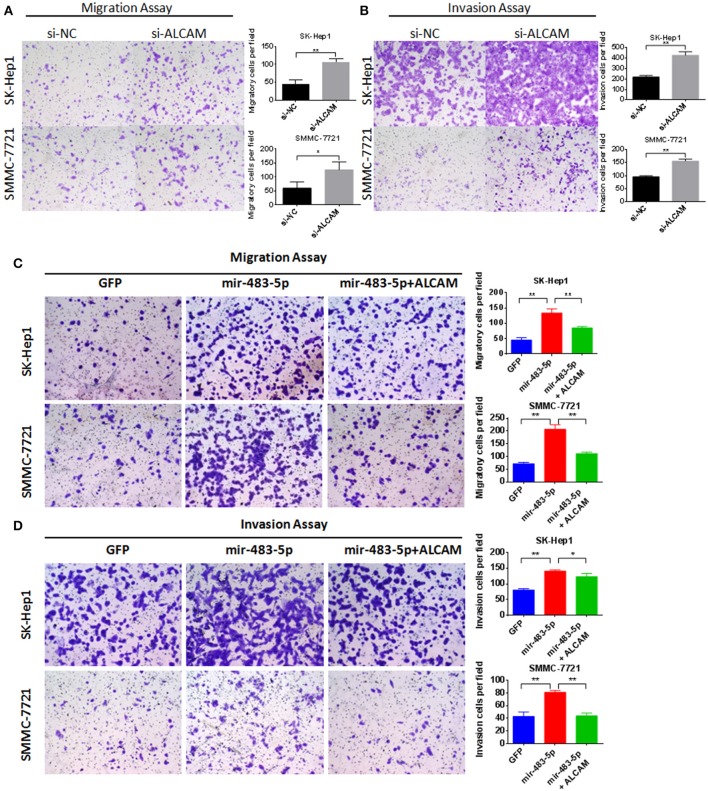
Knockdown of ALCAM can promote HCC cell migration and invasion. Restoration of ALCAM reverses miR-483-5p-mediated HCC cell migration and invasion. (A) Transwell migration assay of SK-Hep1 and SMMC-7721 showed transfection of ALCAM siRNAs promoted cell migration. (B) Transwell invasion assay showed transfection of ALCAM siRNAs promoted cell invasion. (C) The migration of HCC cells induced by miR-483-5p was restored via ALCAM re-introduction. (D) The invasion of HCC cells induced by miR-483-5p was restored via ALCAM re-introduction. *p < 0.05; **p < 0.01 ×40.